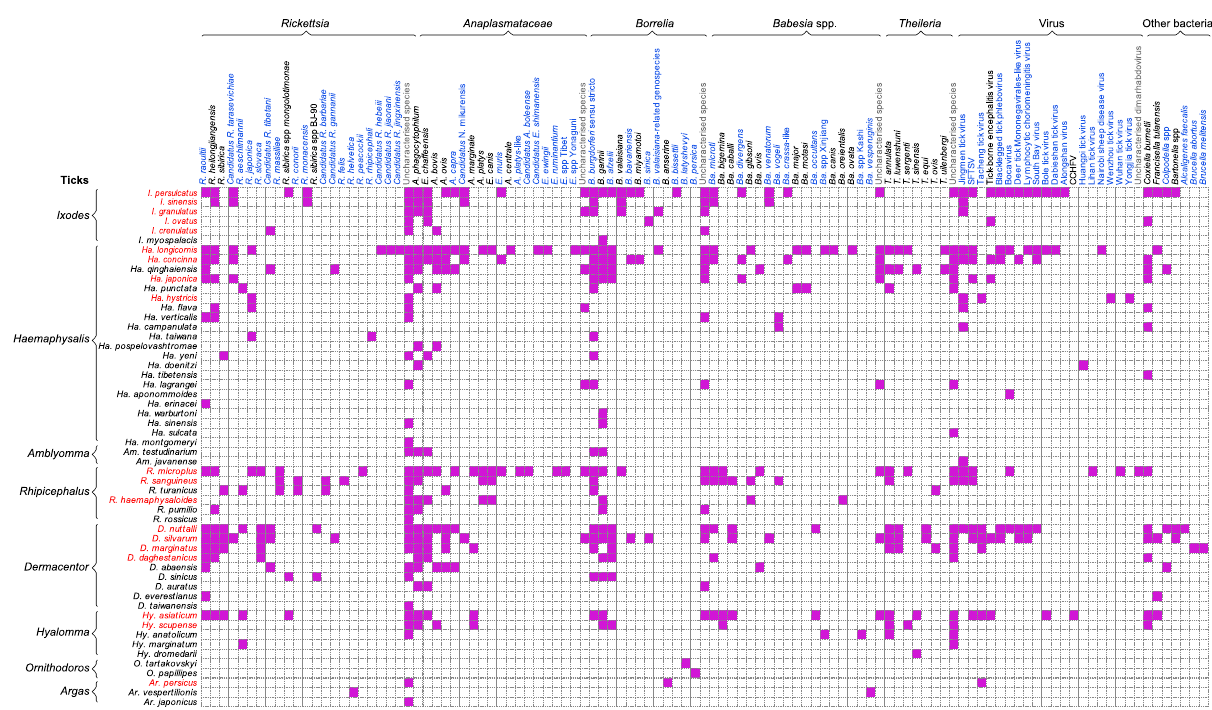
Fig. 3 The tick species and their corresponding tick-borne agents in China from 1950 to 2018. The tick-borne agents marked in blue indicate the newly identi fi ed agents in the past two decades. Source data are provided as a Source Data fi